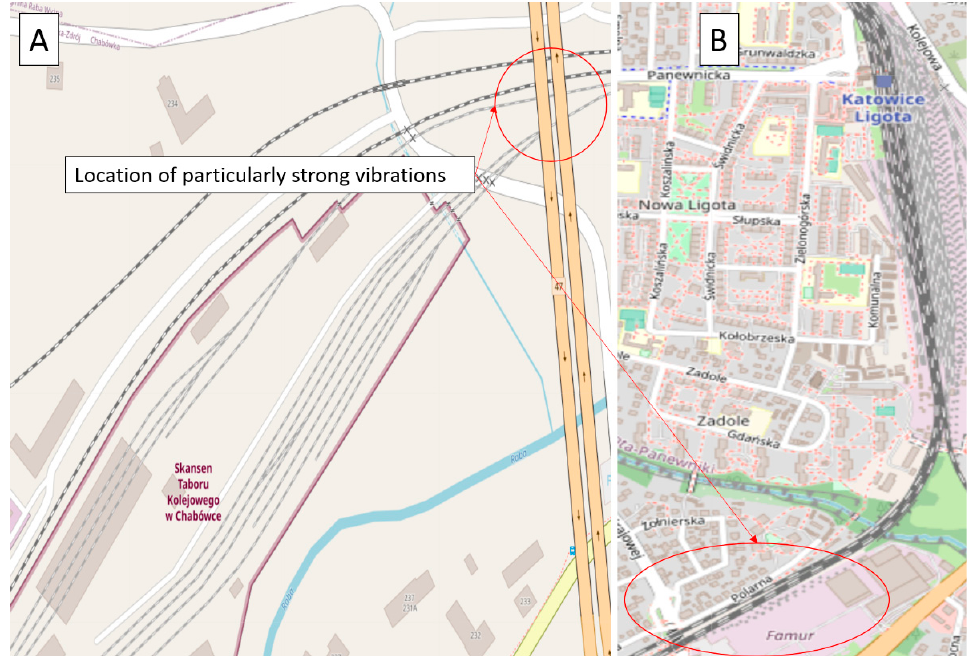
Figure 9. Location of particularly strong vibrations observed in the course of: ( A ) shunting activity at the Chabówka station; ( B ) normal course in Katowice Ligota. Source: authors’ own materials. the Chab ó wka station; ( B ) normal course in Katowice Ligota. Source: authors’ own